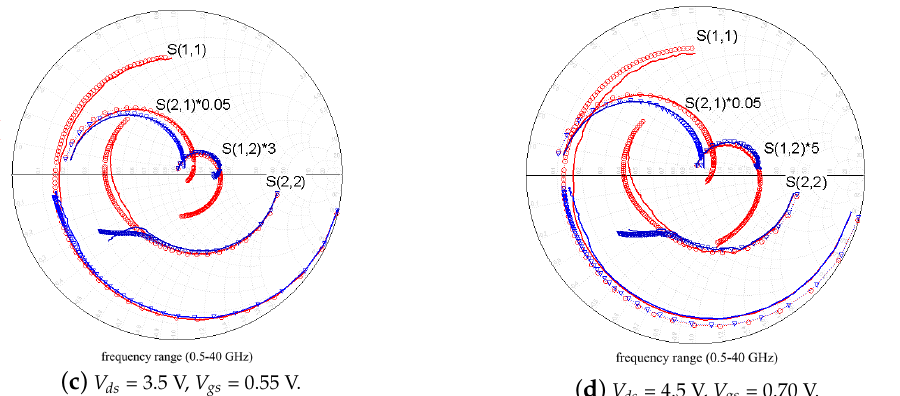
Figure 9. Comparison between simulated (symbol) and measured (solid) S-parameters before (red) and after (blue) applying the “open-short” de-embedding procedure for pHEMT at four different bias conditions, where the DUT operates from the pinch-off region to the saturation region.